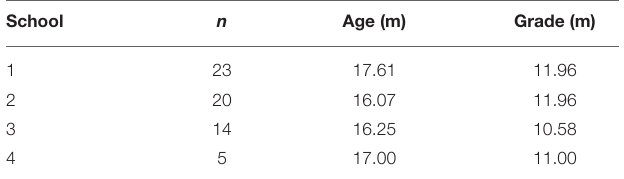
TABLE 1 | Participant ages and grade